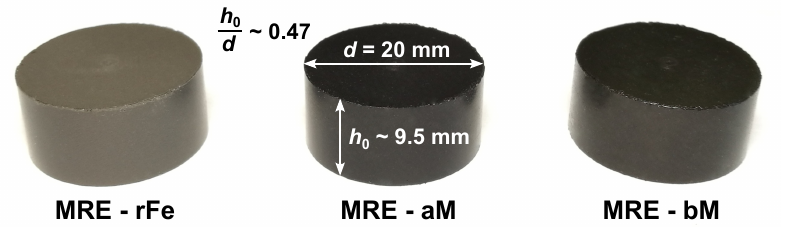
Figure 2. The samples with different fillers: reduced iron powder (rFe), Sigma-Aldrich magnetite (aM), and Bayferrox 318M magnetite (bM). The size of the MREs was the same in all cases as indicated.